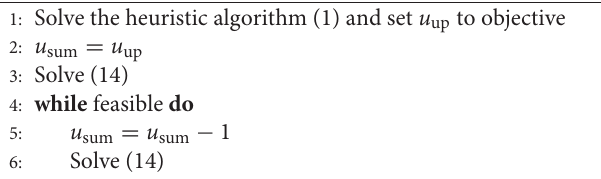
Algorithm 2 : Mixed Integer OCP with T